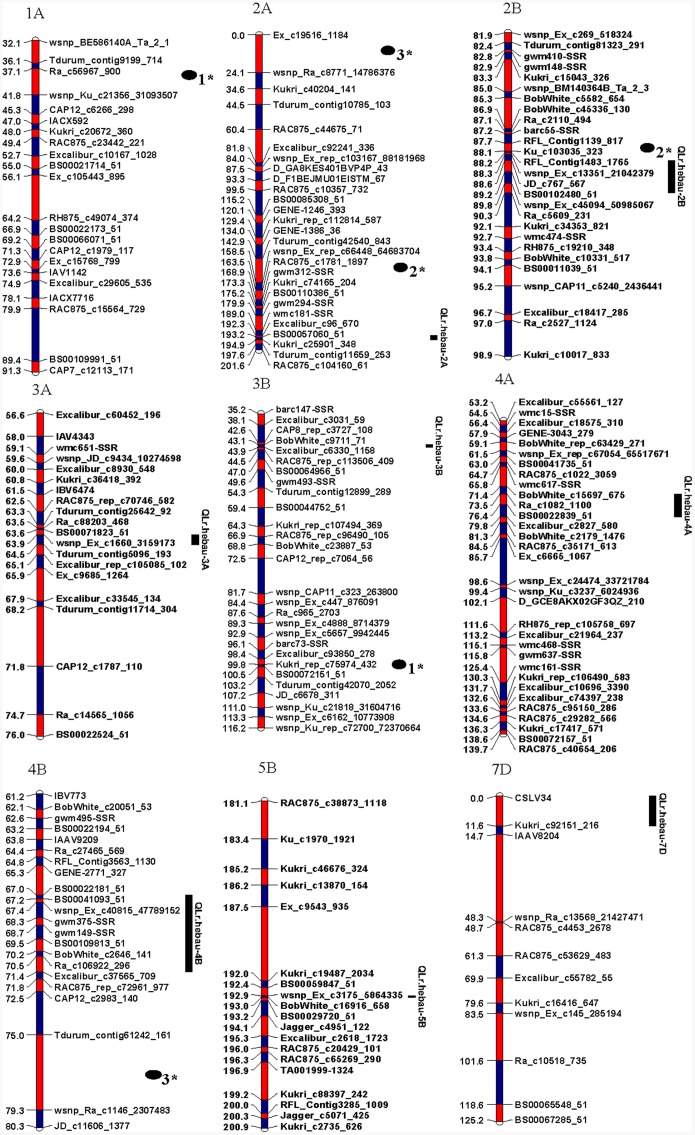
Simplified genetic maps of nine chromosomes showing QTL for leaf rust (LR) resistance in the Zhou 8425B/Chinese Spring population. The bar length of each chromosome do not represent the same genetic distance. The epistasis QTLs also list on the figure. 1∗, 2∗, and 3∗ indicate interactions in 2012BD, 2014BD, and 2015BD, respectively, on the map.